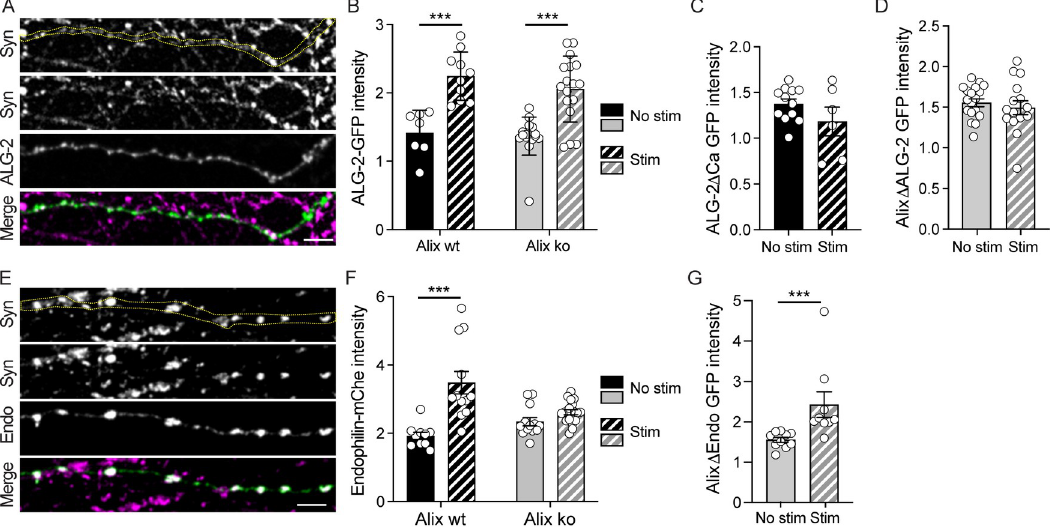
Fig 2. Interplay between Alix, ALG-2, and endophilin recruitments at activated synapses. All experiments made use of 15 DIV hippocampal neurons expressing the indicated constructs. Neurons were stimulated with Bic/4AP for 5 min before fixation and stained with anti-synapsin-1 (Syn, magenta). ( A ) GFP-ALG-2 (green) is recruited presynaptically upon stimulation. The yellow dashed line indicates the position of the axon in the synapsin-I channel (upper panel). Scale bar: 5 μ m. ( B ) Quantification of synaptic recruitments of GFP-ALG-2 in Alix wt (black) and Alix ko (gray) neurons shows that ALG-2 presynaptic recruitment does not depend on Alix. ( C ) Quantification of synaptic recruitments of GFP-ALG-2 Δ Ca in Alix wt neurons (black) shows that ALG-2 presynaptic increase depends on its capacity to bind calcium. ( D ) Quantification of synaptic recruitments of GFP-Alix Δ ALG-2 in Alix ko neurons shows that Alix recruitment depends on its capacity to bind ALG-2 as GFP-Alix Δ ALG-2 is not recruited upon stimulation of Alix ko neurons. ( E ) Endophilin-mCherry (endo, green) concentrates at presynaptic parts of stimulated neurons. The yellow dashed line indicates the position of the axon in the synapsin-I channel (upper panel). Scale bar: 5 μ m. ( F ) Synaptic recruitment of endophilin-mCherry following synaptic activation requires Alix as it is impaired in Alix ko neurons. ( G ) Quantification of synaptic recruitments of GFP-Alix Δ endo in Alix ko neurons shows that Alix recruitment does not depend on its binding to endophilins. Average +/ − SEM, N , statistical analysis: (B) 1.41 +/ − 0.13; 2.24 +/ − 0.11; 1.36 +/ − 0.06; 2.06 +/ − 0.12 for Alix wt no stim, Alix wt stim, Alix ko no stim, Alix ko stim, respectively. N = 7, 10, 17, 17 neurons for GFP-ALG-2 in Alix wt no stim, Alix wt stim, Alix ko no stim, Alix ko stim, respectively, from 3 experiments. p = 0.0001 for all the conditions tested, 1-way ANOVA. (C) 1.8 +/ − 0.05; 1.18 +/ − 0.16 for GFP-ALG2 Δ Ca in no stim and stim conditions, respectively. N = 12 and 6 neurons for no stim and stim, respectively. (D) 1.54 +/ − 0.05; 1.48 +/ − 0.08 for GFP-Alix Δ ALG-2 in no stim and stim conditions, respectively. N = 18 and 15 neurons for no stim and stim, respectively, from 3 independent experiments. (F) 1.92 +/ − 0.11; 3.48 +/ − 0.33; 2.34 +/ − 0.12; 2.61 +/ − 0.08 for endophilin-mche in Alix wt no stim, Alix wt stim, Alix ko no stim, Alix ko stim, respectively. N = 10, 12, 13, 19 neurons for Alix wt no stim, Alix wt stim, Alix ko no stim, Alix ko stim, respectively, from 3 independent experiments. Alix wt no stim vs. Alix wt stim, p < 0.0001, 1-way ANOVA. (G) 1.56 +/ − 0.06; 2.43 +/ − 0.32 for GFP-Alix Δ endo in no stim and stim conditions, respectively. N = 10 and 9 neurons for no stim and stim, respectively, from 3 independent experiments. No stim vs. stim, p = 0.0004, Mann– Whitney test. The data underlying all the graphs shown in the figure can be found in S1 Data. Alix, ALG-2-interacting protein X; DIV, day in vitro ; ko, knockout; wt, wild type.